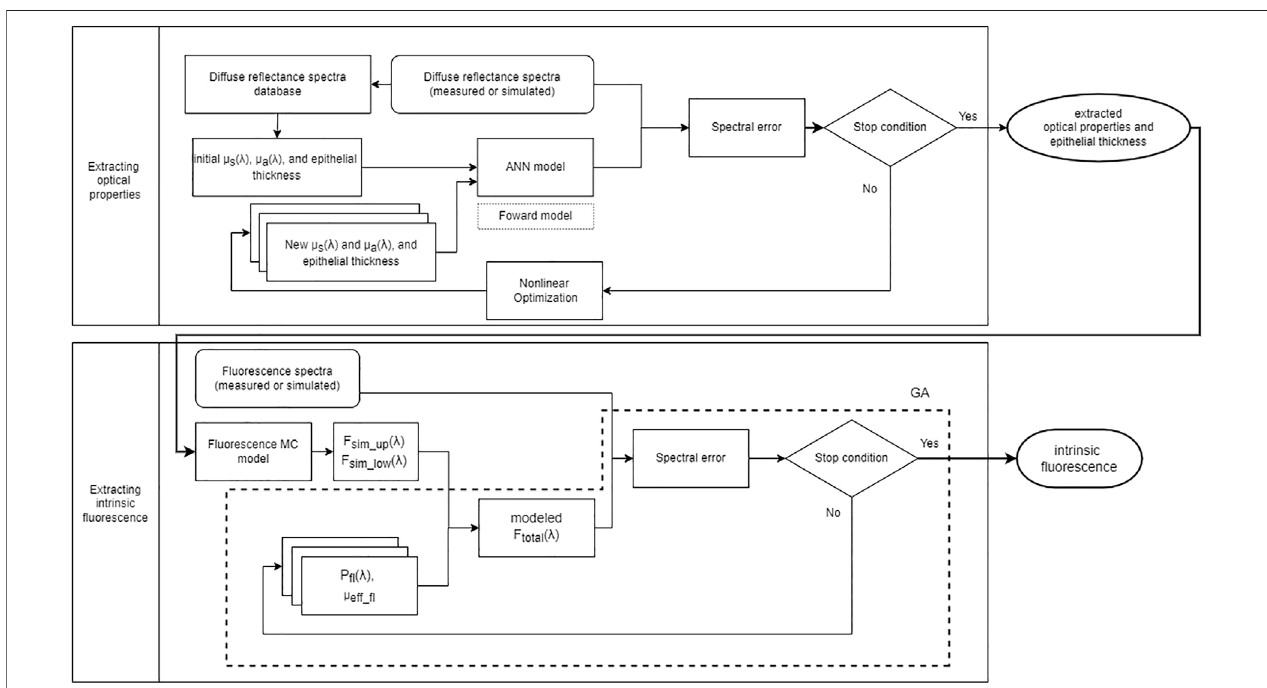
FIGURE 1 | Flowchart of the proposed method to extract intrinsic fl uorescence. The upper half shows iterative curve fi tting to estimate μ a ( λ ), μ s ( λ ) and epithelial thickness of the two-layer cervical mucosa model based on ANN forward models trained with MC simulations. The lower half shows the process to model fl uorescence spectra and estimate the ef fi ciency and spectral shape of intrinsic fl uorescence using the genetic algorithm